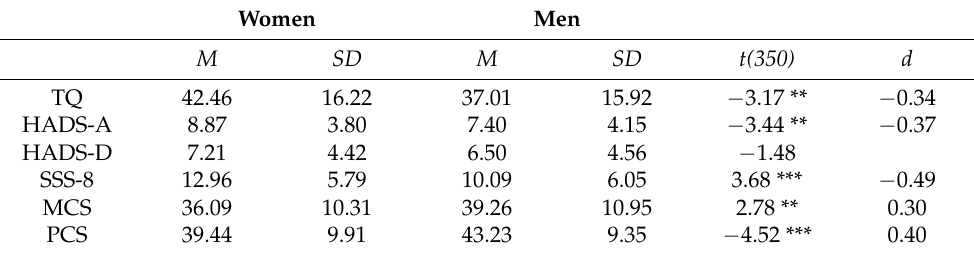
Table 5. Between-gender differences for the obtained measures (independent-samples t